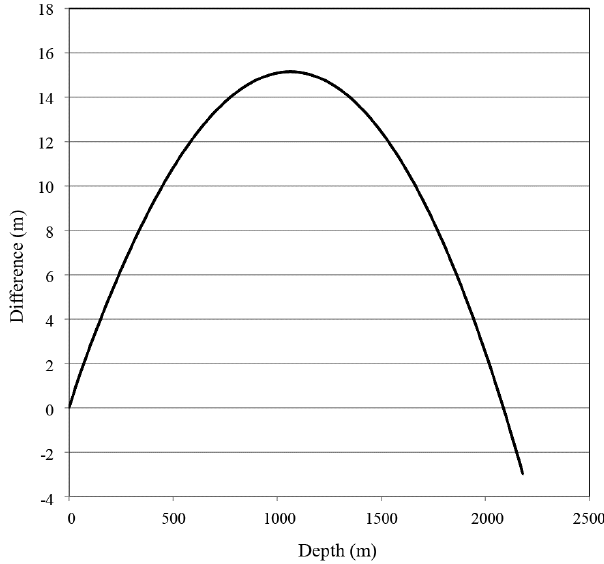
Fig. 6b – Difference in depth calculations (new method – manufacturer FRE). Fig. 6b. Difference in depth calculations (new method – manufac- turer